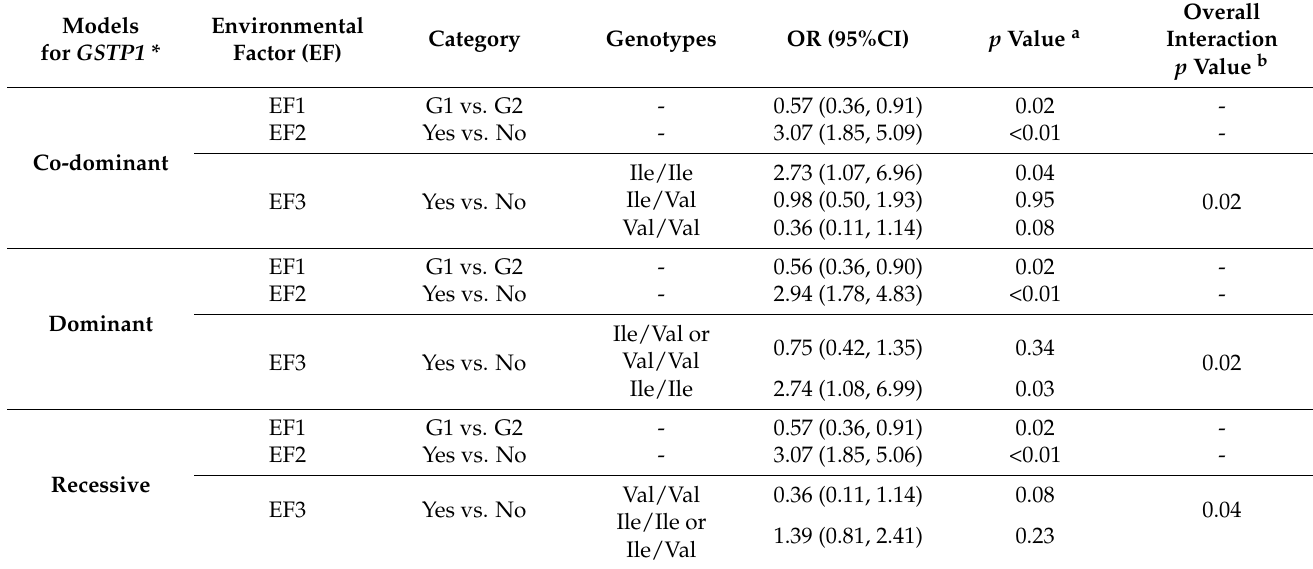
Table 5. Adjusted associations between exposure to environmental factors and binary detectable blood Al concentrations (BAlCs) by genotypes for GSTP1 genes in typically developing children based on logistic regression models that include gene*environment interaction (N =